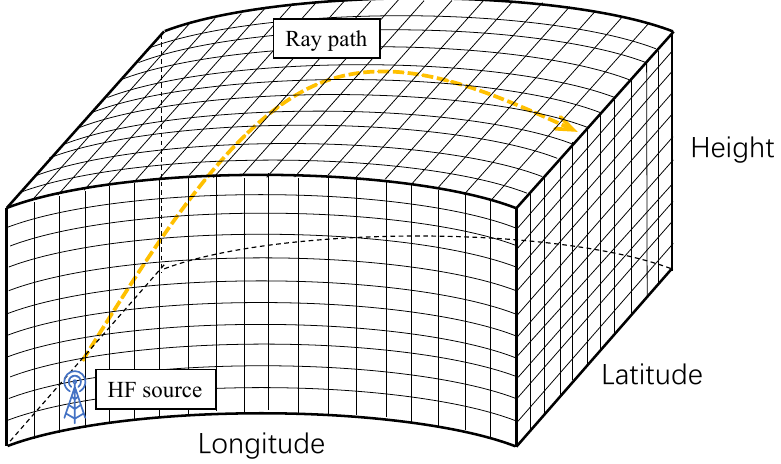
Figure A1. 3D gridded matrix of the ionospheric electron density.